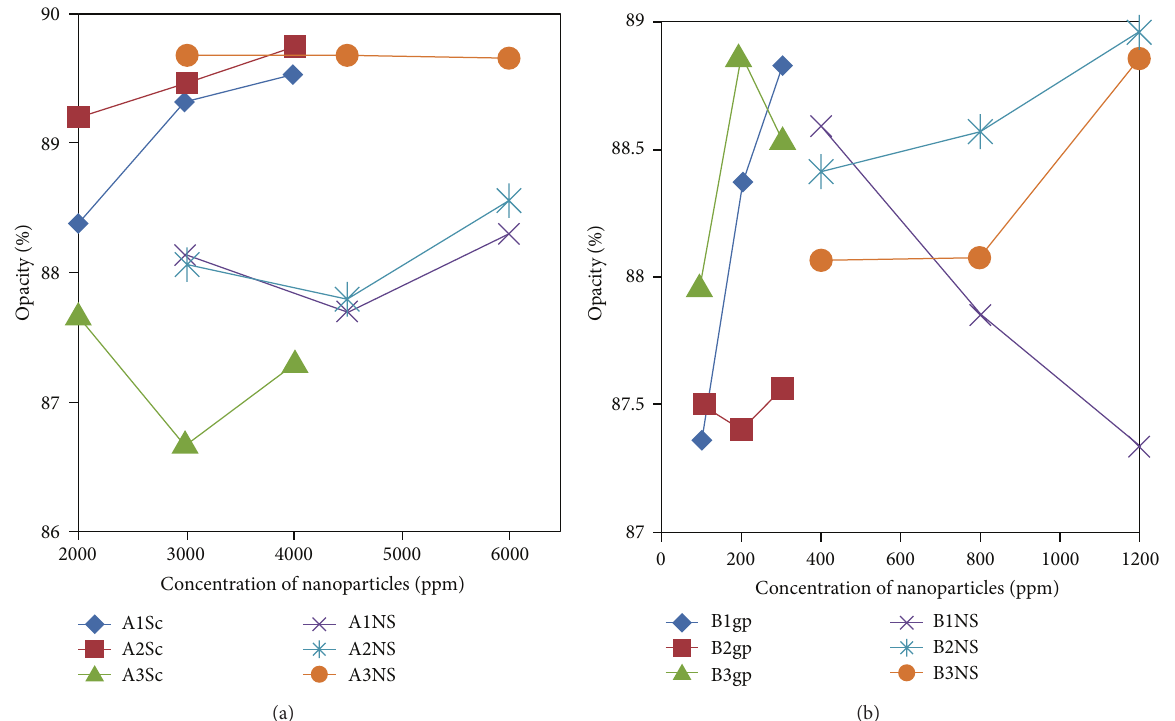
Figure 8: Effects of substituting NS for (a) Sc and (b) gp on the handsheet